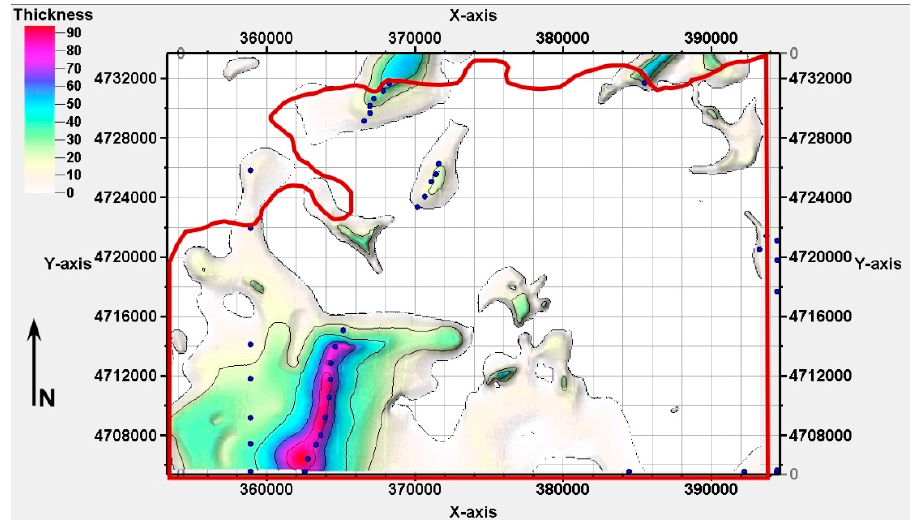
Figure 13. Isopach map of the Pre-Illinois Unit. Dark blue dots represent synthetic well locations. Thickness is in meters.